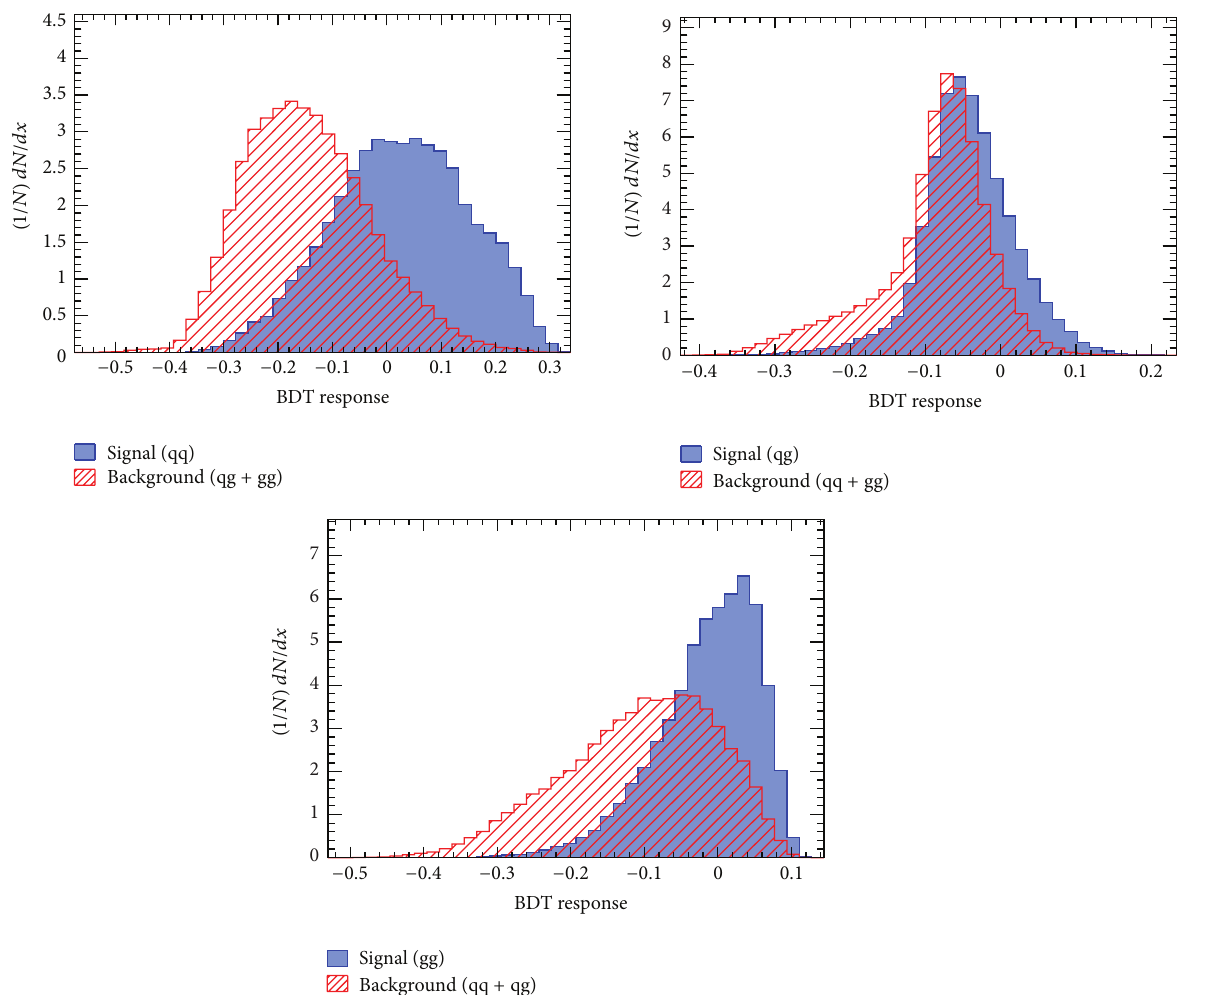
Figure 2: The output distribution of Boosted Decision Tree technique for each type of parton pair separation. Blue solid histograms show signal of a particular parton pair and red hatched ones present background that comes from other two types of parton